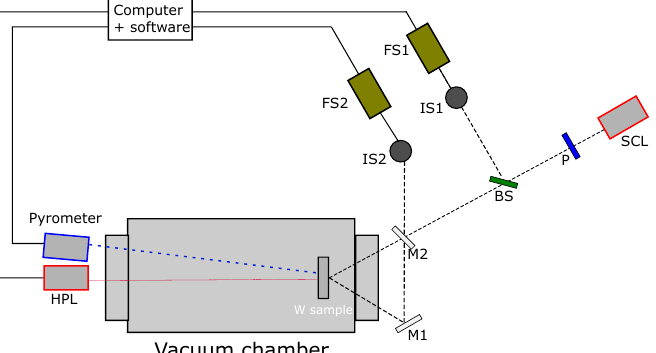
Figure 1. Schematic of the experimental setup: HPL, high power laser; SCL, supercontinuum laser; P, polarizer; BS, beam splitter; M1 and M2, fixed and removable silver mirrors, respectively; IS1 and IS2, integrating spheres of reference and sample side, respectively; FS1 and FS2, fiber-optic spectrometers connected to IS1 and IS2,